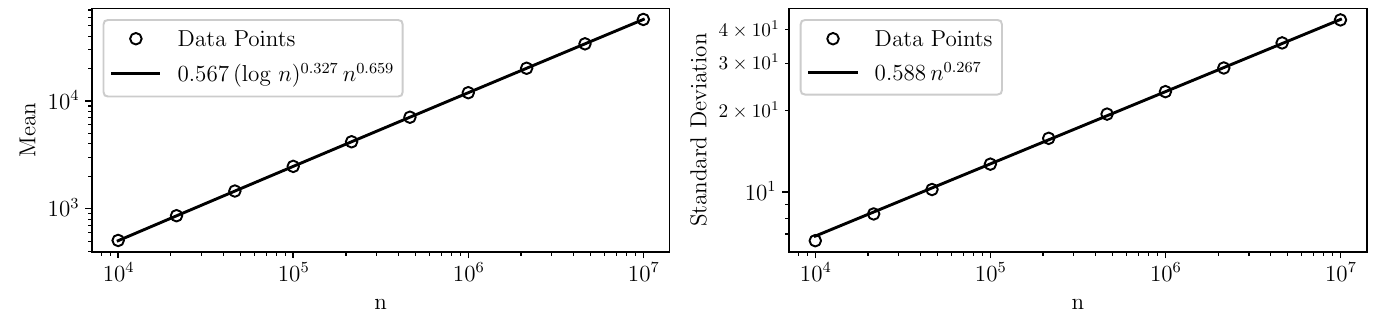
Figure 3: Log-Log plots of the best fits for the mean and standard deviation of the number of particles in model-I. The data